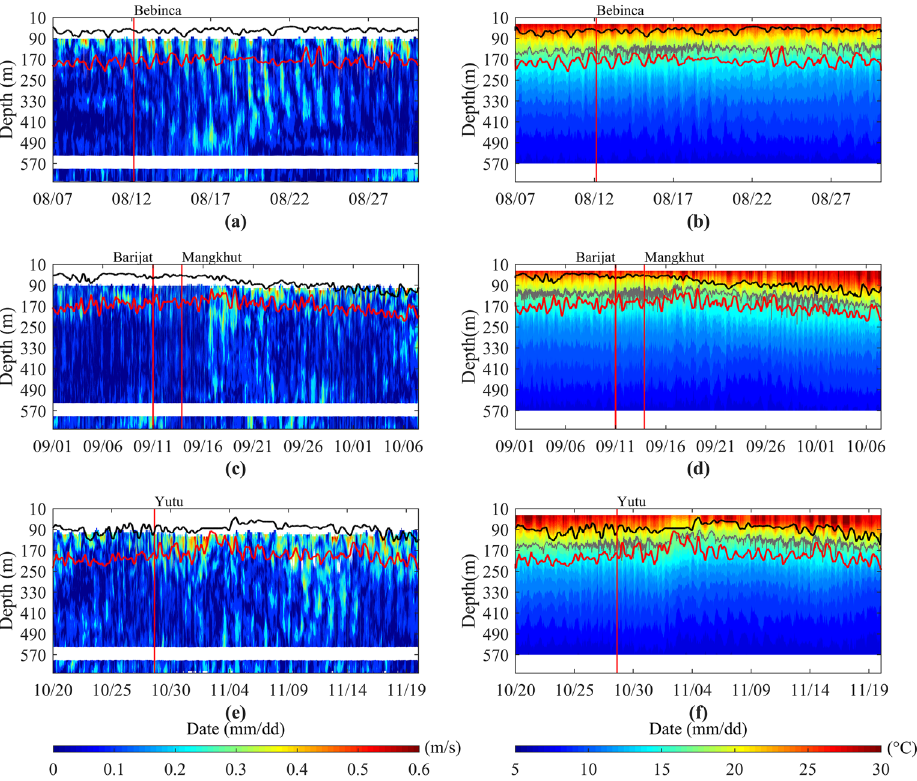
Figure 2. Time series of the current velocity ( a,c,e ) and temperature ( b,d,f ) during the passage of typhoons Bebinca ( a,b ), Barijat and Mangkhut ( c,d ), and Yutu ( e,f ) versus depth, respectively. The x-axis is in the format of month/day. The red vertical lines are same as Fig. 1. The red horizontal lines are the lower boundary of the thermocline. The gray horizontal lines are 18 °C isotherm, and the black horizontal lines are the depth of the strongest